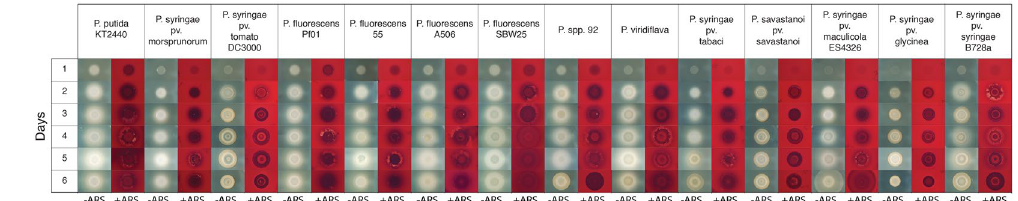
Figure 2. Pictures of Pseudomonas species grown on NB agar supplemented with calcium over the course of six days. Pictures were taken of the same colony before ( − ) and after ( + ) staining of the colonies with 1.0% (w/v) ARS. These pictures are representative of growth for each Pseudomonas species on NB agar with calcium. The assay was repeated five separate times and the pictures are representative of those